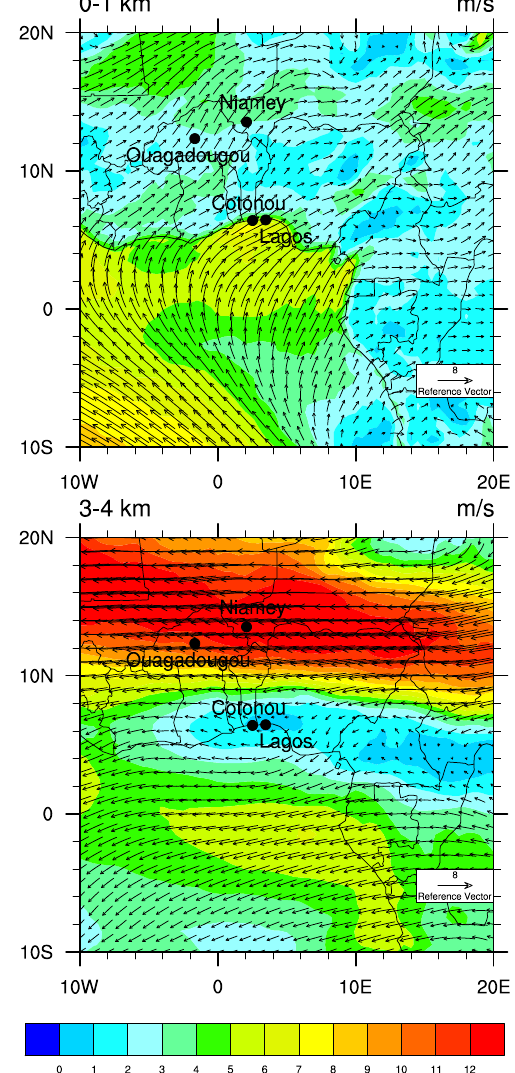
Fig. 1. Wind velocity (ms − 1 ) and vectors from ECMWF reanalysis averaged over August 2006 for the 3–4km (bottom), and 0–1km (top) tropospheric layers.